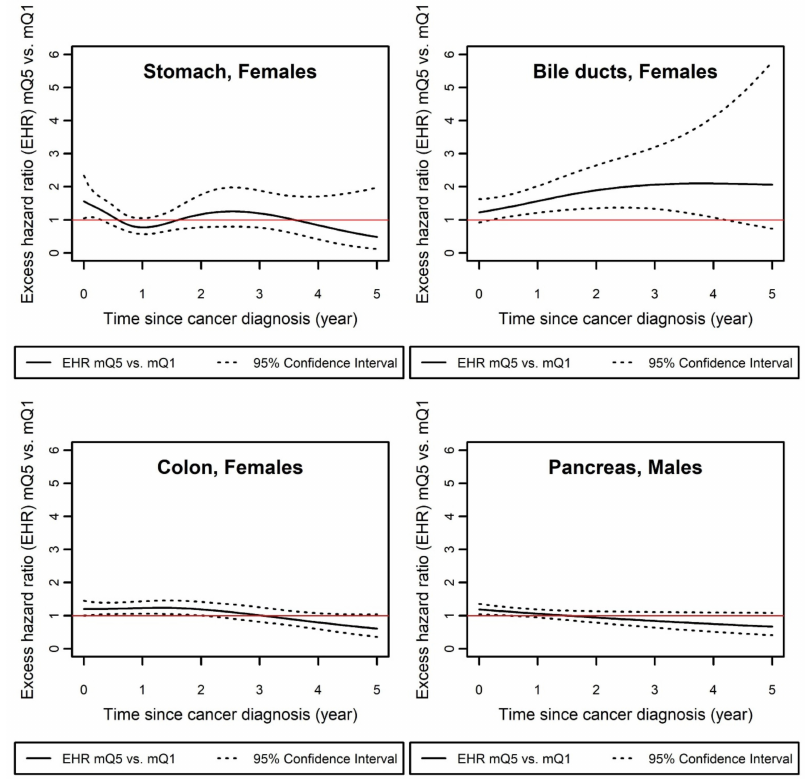
Figure 2. Excess hazard mortality ratio (EHR) between mQ5 (most deprived) and mQ1 (least deprived), over time for cancer sites for which effect of EDI on net survival was time-dependent (M1b selected). EHR: excess mortality hazard ratios; mQ i : median value of national deprivation quintile i (see Section